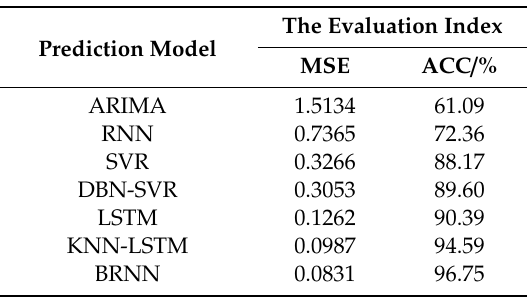
Table 3. Prediction performance of di ff erent